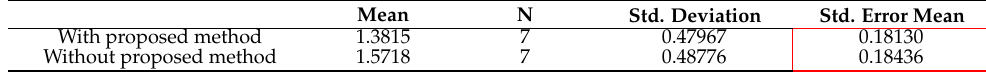
Table 15. Results of the paired-sample t -test for average interaction latency for each subject: statistics.